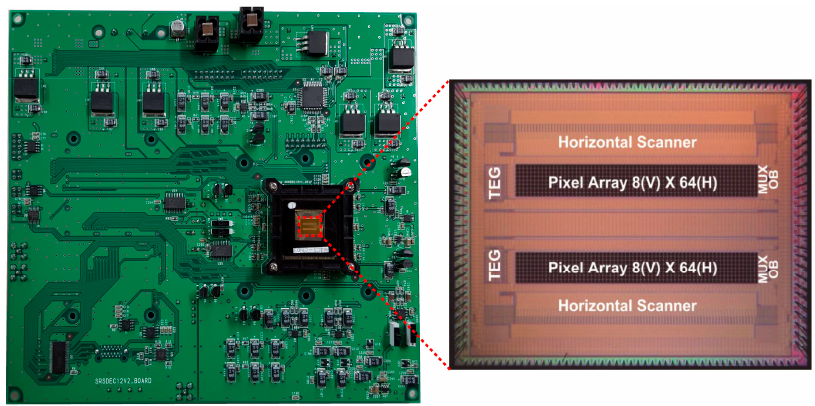
Figure 14. Photograph of the PCB sensor board with micrograph of the prototype SRS CMOS imager. The chip consists of 64 × 8 pixel array, horizontal scanner as pixel selector, and output buffer amplifiers.